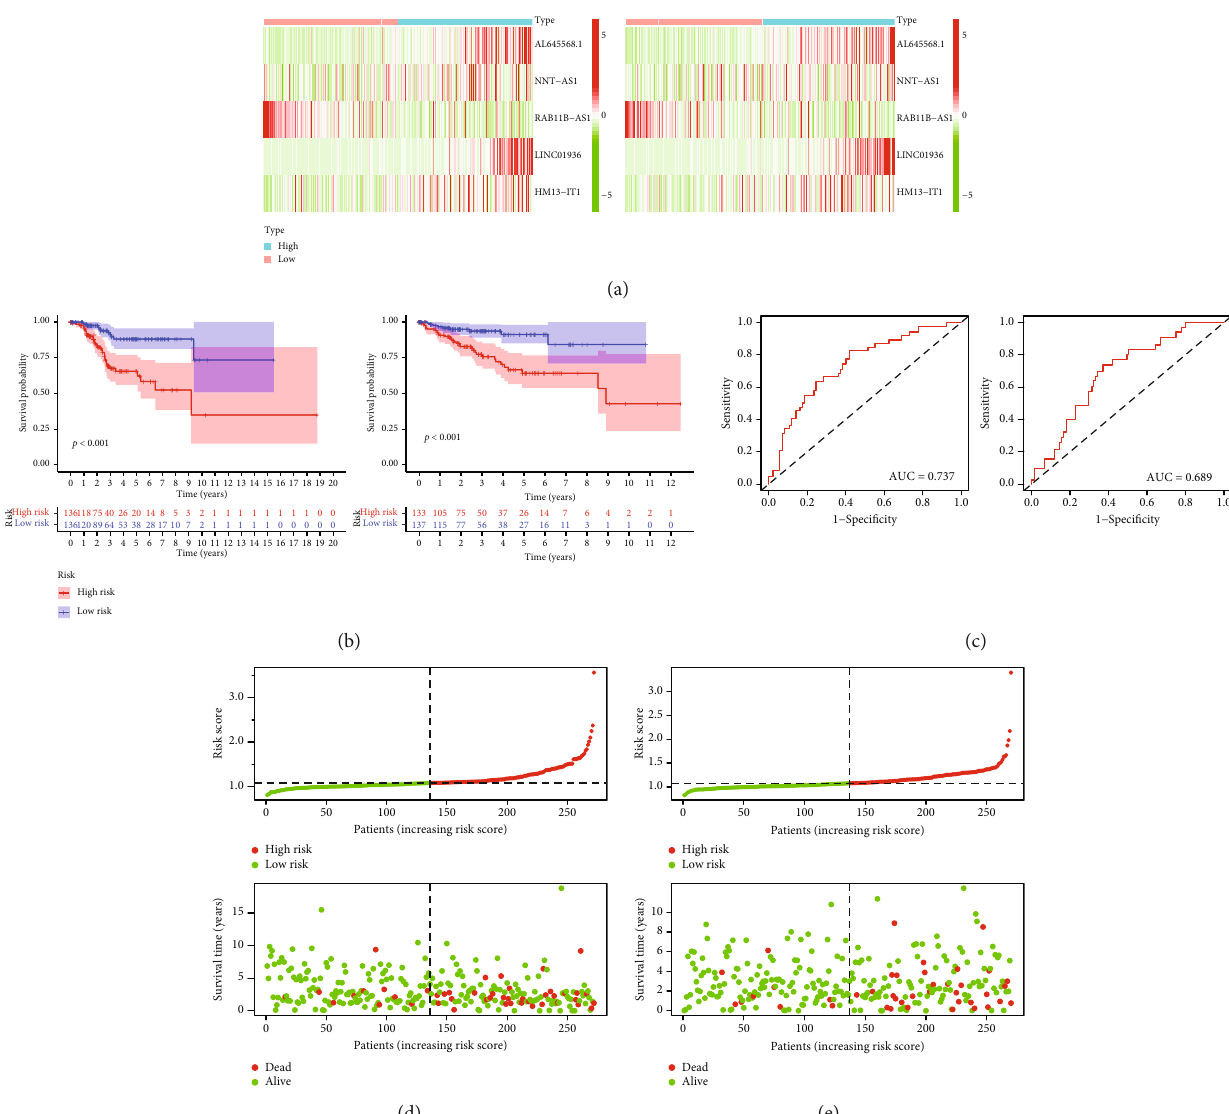
Figure 5: (a) Expression heatmap of major m6A-relevant lncRNAs of prognostic signi fi cance in two risk groups (high and low). (b) Patients in the two risk groups (high and low) in the training and test groups by Kaplan – Meier analysis. (c) The ROC curves of patients showing high and low risk scores in the training and test groups ( AUC = 0 : 74 and 0.69, respectively). (d, e) The risk plots and survival of high-risk and low-risk patients in the training and test groups. AUC: area under the curve; ROC: receiver operating